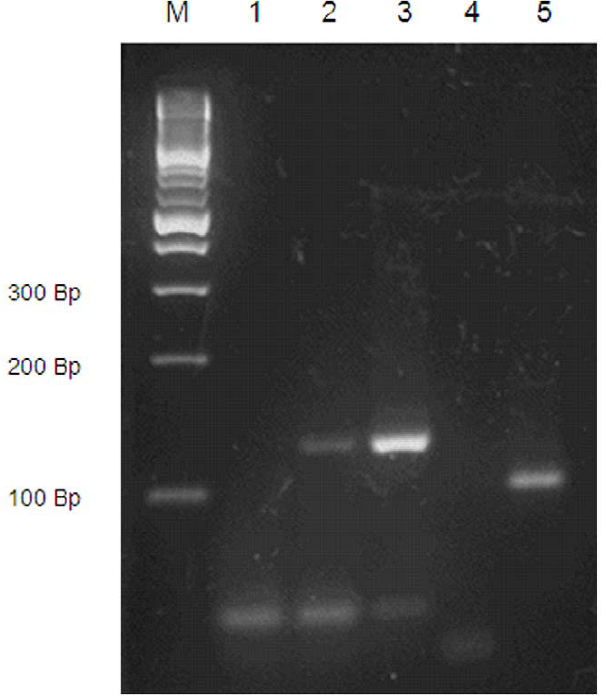
Figure 6. Evidence of Myo15 expression in the rat retina. Agarose gel results of PCR products obtained from retinas of LEW/Ztm rats. Lane M contains the DNA ladder; lane 1 contains the negative control reaction (no cDNA template, Myo15 primers); lane 2 contains cDNA (10 ng) obtained from the retina ( Myo15 primers, expected length of the fragment 125 bp); lane 3 contains positive control, cDNA (10 ng) obtained from the pituitary gland ( Myo15 primers, expected length of the fragment 125 bp); lane 4 contains negative control reaction (no cDNA template, ß-Actin primers); lane 5 contains cDNA obtained from the retina ( ß-Actin primers, expected length of fragment 101 bp).